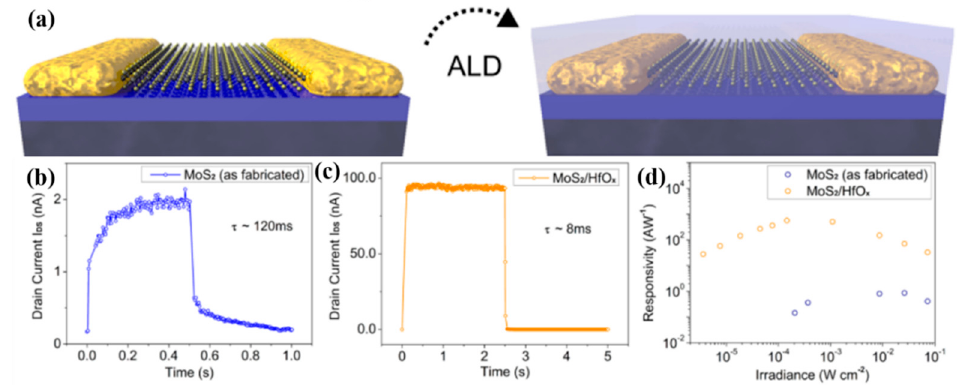
Figure 4. ( a ) Device schematic of MoS 2 and MoS 2 / HfO 2 photodetectors (PDs). The photocurrent of MoS 2 before ( b ) and after ( c ) HfO 2 encapsulation. ( d ) The power-dependent responsivity of a bilayer MoS 2 device before and after HfO 2 encapsulation [82] .